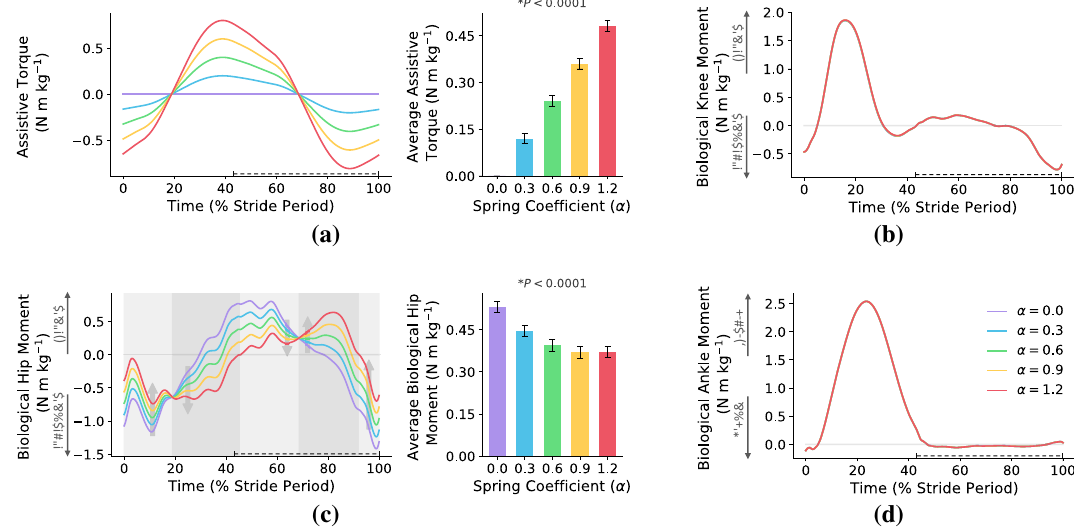
Figure 3. Joints’ torques . This figure shows the effects of exoskeleton augmentation on the joints’ biological moments and their average over the whole stride. The start of the gait cycle is at the heel-strike instant of the right leg, and all of the figures are for the right leg. The swing phase is shown with a dashed line over the horizontal axes. ( a ) is the exoskeleton torque profile for different stiffness coefficients. ( b – d ) show the biological knee, hip, and ankle moments. As it is clear, the exoskeleton augmentation only affects the biological hip moment, and the moments of the knee and ankle are not changed; thus, we have not plotted the average torque of the knee and ankle joints. The background color code for ( c ) is: light and dark gray mean biological hip moment improvement and disruption/increment, respectively. Moreover, the minimum of the average biological hip moment is on α = 1 where it has 31% reduction compared to no exoskeleton case. And, the reduction of the average biological hip moment for α ∗ = 0.6 is 26% . N = 7 ; bars, mean; error bars, s.e.m; P values, ANOVA (random effect: participant; fixed effects: spring coefficient; significance level = 0.05